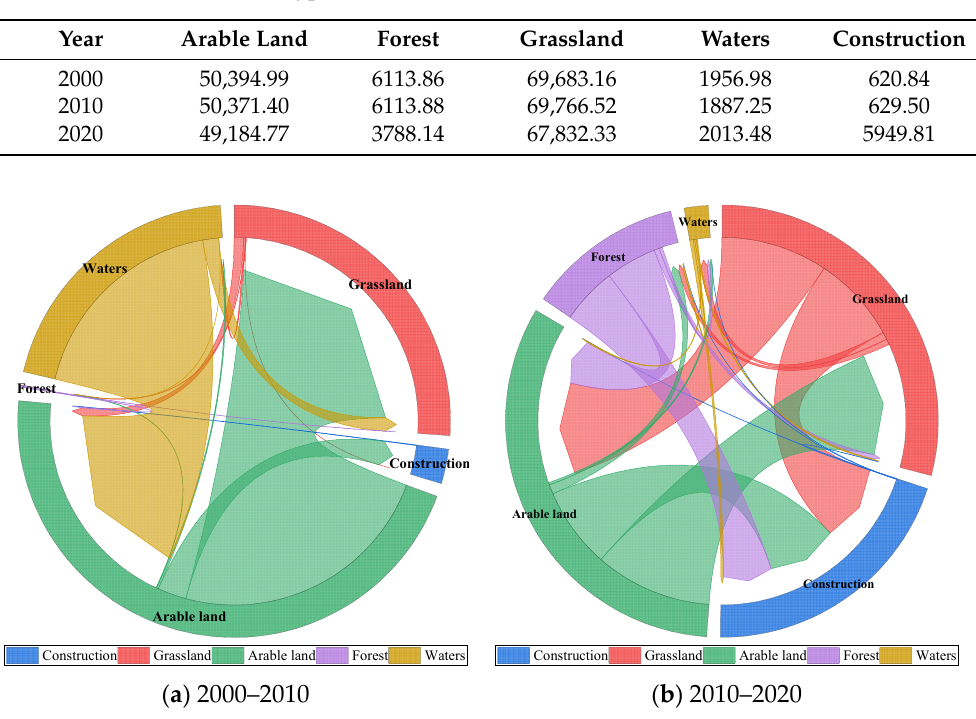
Table 4. The area of land use type from 2000 to 2020 (unit: hm 2 ).